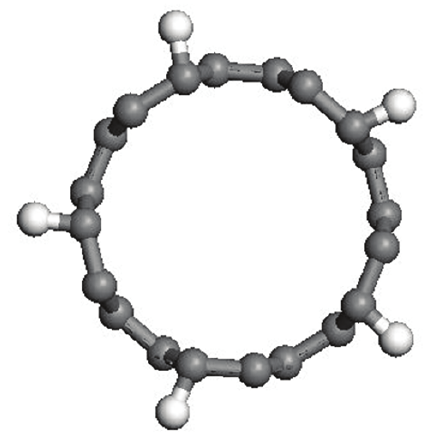
Figure 1: Cross-section of CNT functionalized by H atoms.